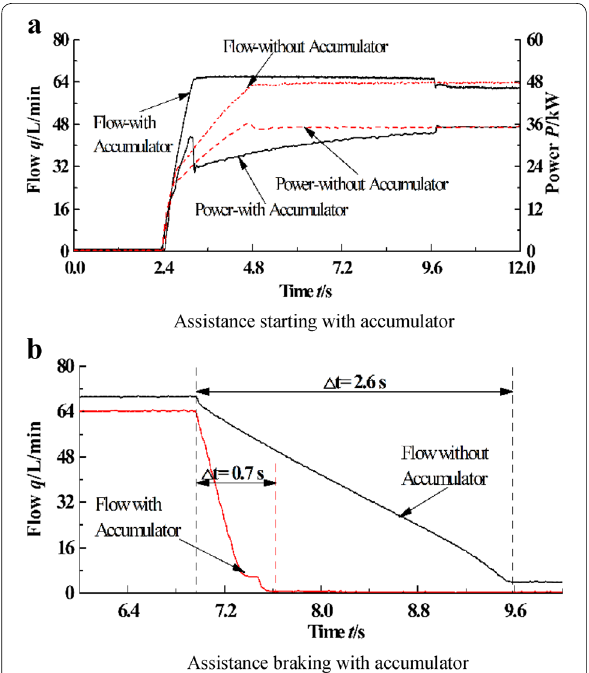
Figure 7 Performance of the starting and braking with accumulator